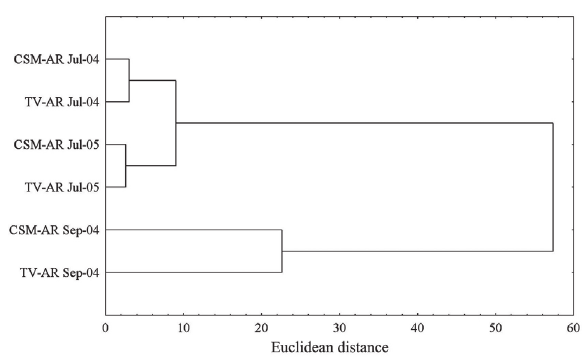
Fig . 4. – Results of cluster analysis of the sampling surveys carried out in the artificial reefs of Capo S. Marco (CSM-AR) and Torre Verdura (TV-AR) based on the density of potential fish preys and competitors of E. marginatus .